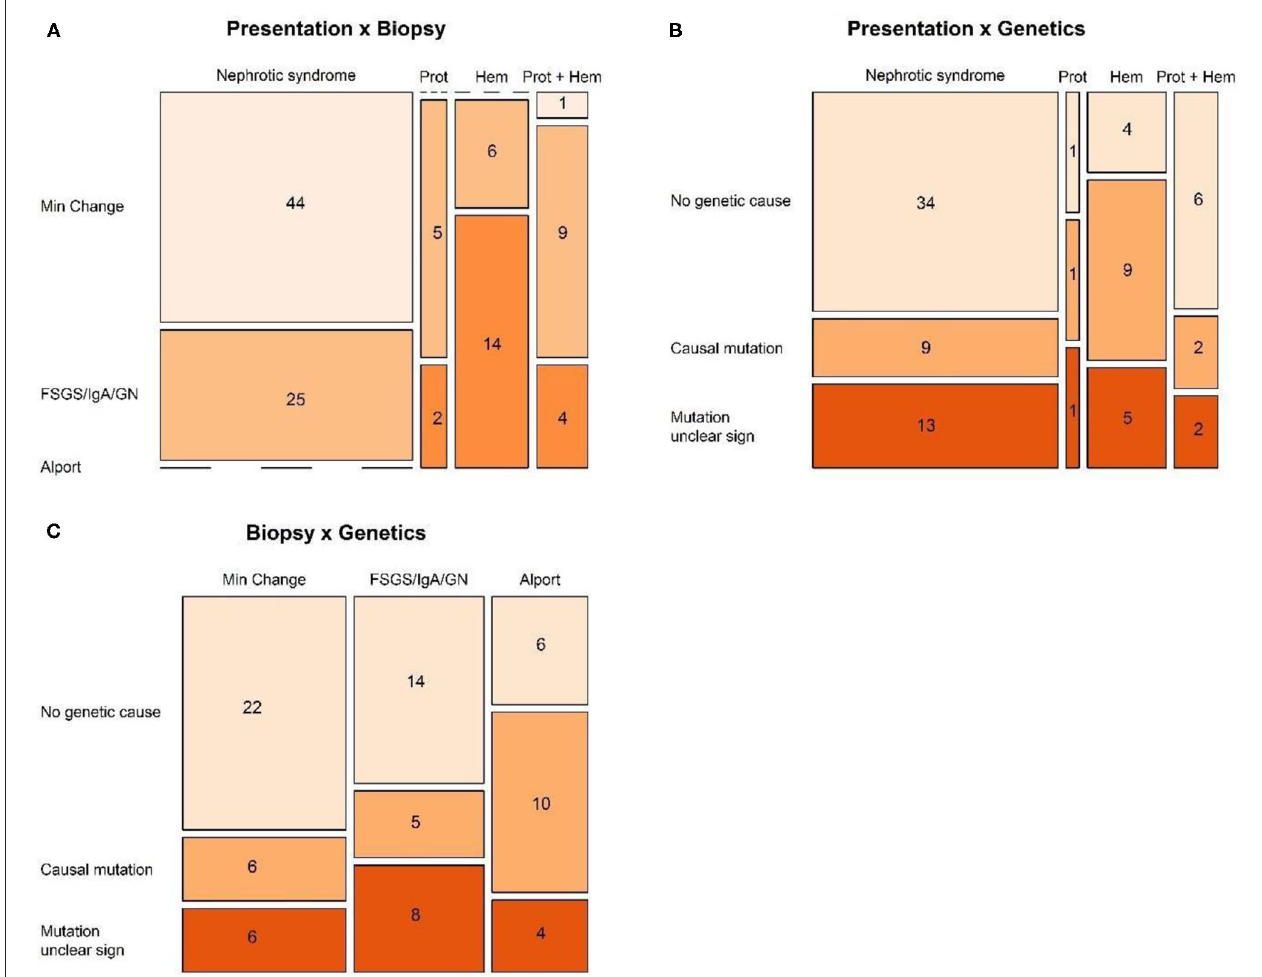
FIGURE 1 | Mosaic plots visualizing the relation between (A) presentation and biopsy, (B) presentation and genetics, and (C) biopsy and genetics.